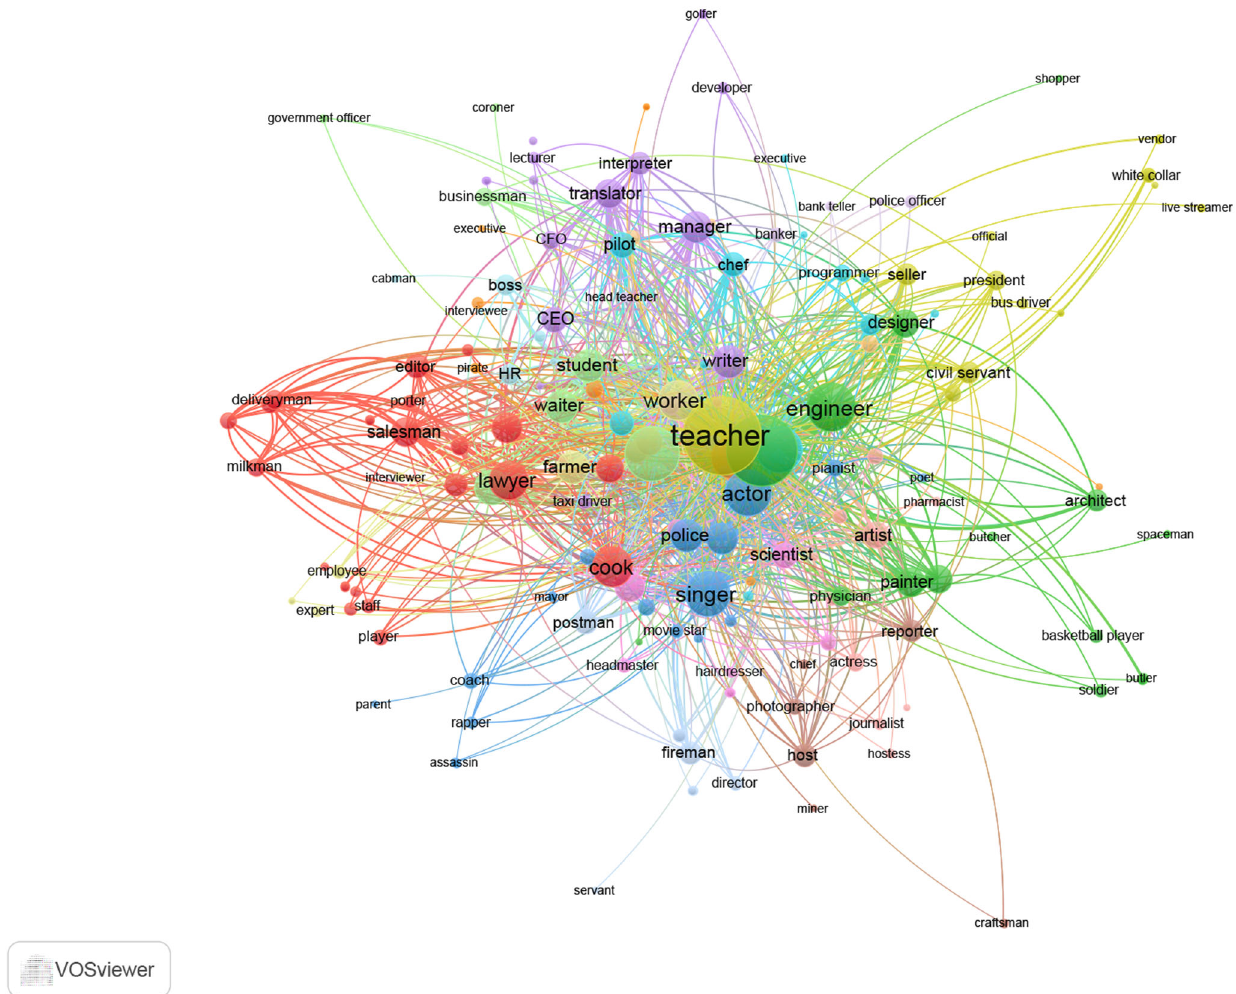
Fig. 2 The L2 lexical-semantic network of the graduates. The size of nodes represents the number of links and the color of links signi fi es clusters.